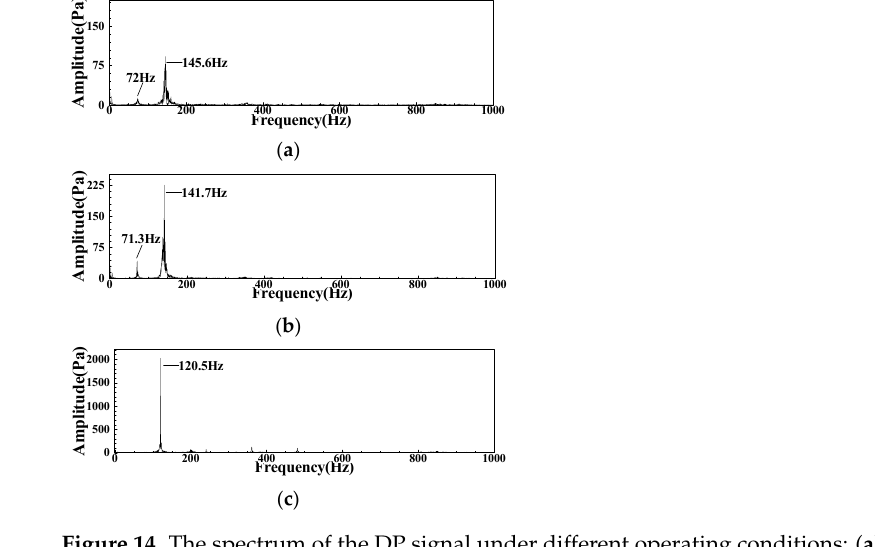
Figure 13. DP signal within 0–2 s under each operating condition of group LA: ( a ) LA01; ( b ) LA02; ( c ) LA03; ( d ) LA04; ( e ) LA05; ( f ) LA06. The spectrum result of DP signal in LA01-LA03 is obtained after FFT calculation, as shown in Figure 14. In the LA01 and LA02 operating conditions, the pulsation peak will increase with the decrease of the fuel–air ratio, and the frequency of the main peak will decrease, but all around 140 Hz. The sub peak near 70 Hz also has similar changes. In LA03, due to the influence of CI, the pulsation peak will increase sharply. Simultaneously, there is a single main peak of 120 Hz in the pulsation spectrum and no other obvious secondary peak. The other operating conditions of group LA are in the CI state, and the pulsation spectrum is similar to LA03.